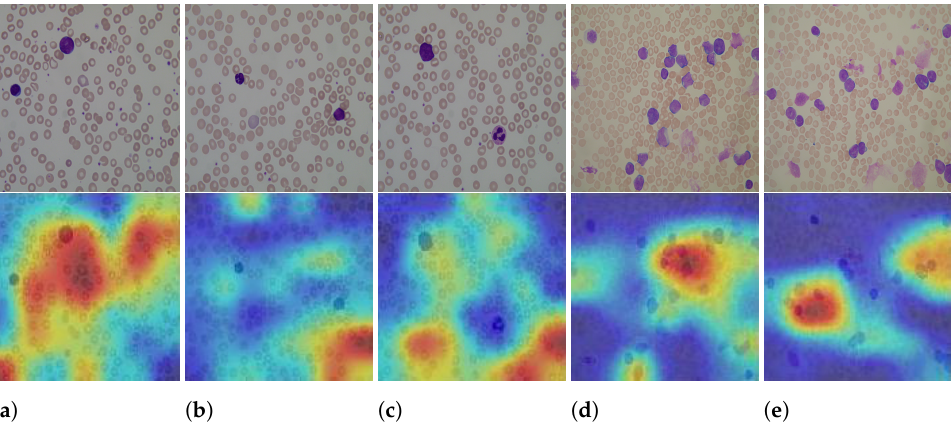
Figure 5. Visual Grad-CAM explanations for ResNet-50 exploited on the original test set images belonging to the ALL category. ( a ) Image n. 31 ( b ) Image n. 32 ( c ) Image n. 33 ( d ) Image n. 48 ( e ) Image n.